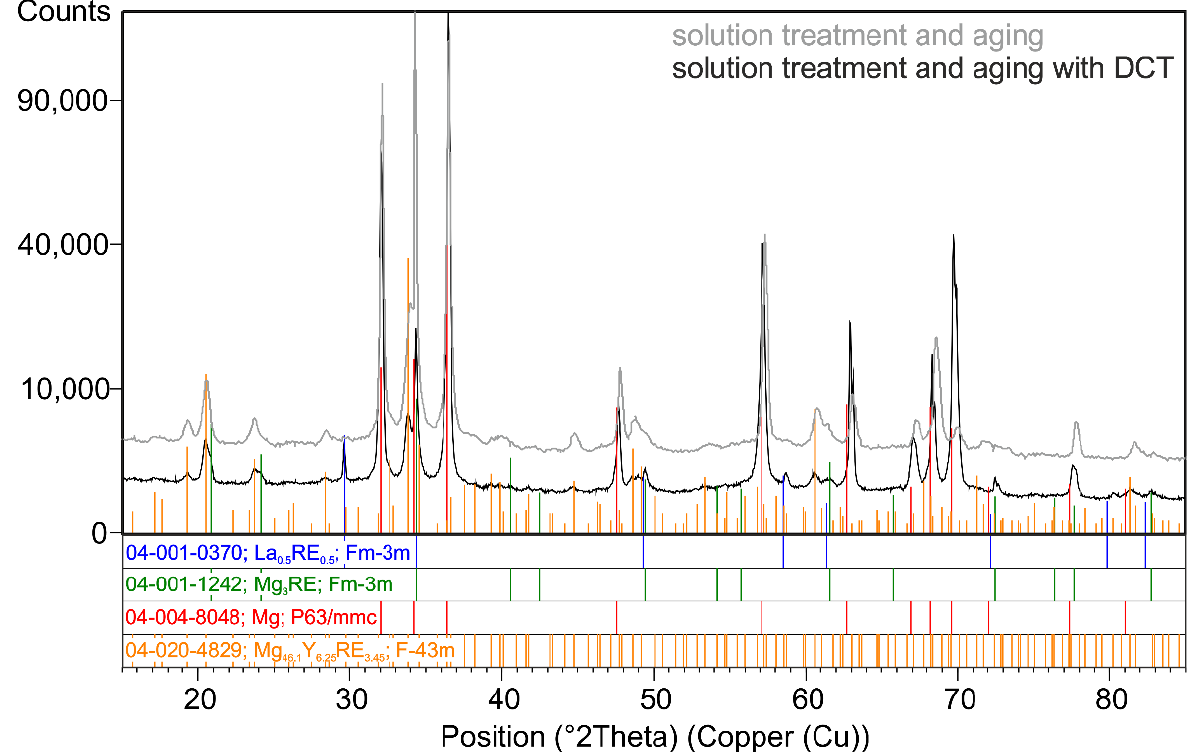
Figure 4. X-ray diffraction pattern (XRD) of the Mg-Y-Nd alloy after precipitation hardening ( a ) and after precipitation hardening with a deep cryogenic treatment ( b ).